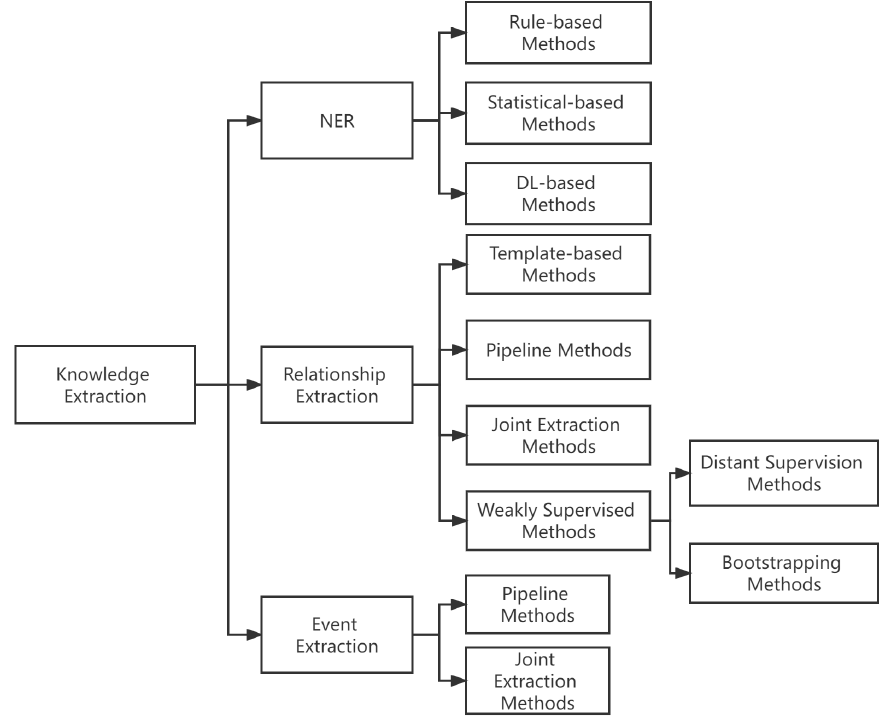
Figure 4. Categorization of knowledge extraction